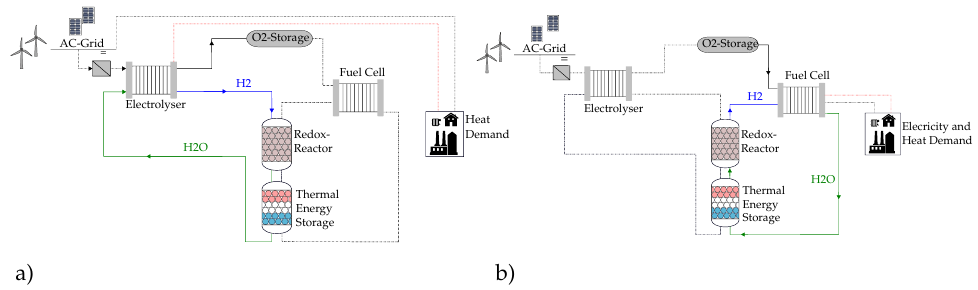
Figure 1. Schematic of a renewable energy storage and supply system based on the redox concept. ( a ) Charging phase and ( b ) discharging phase (inspired by